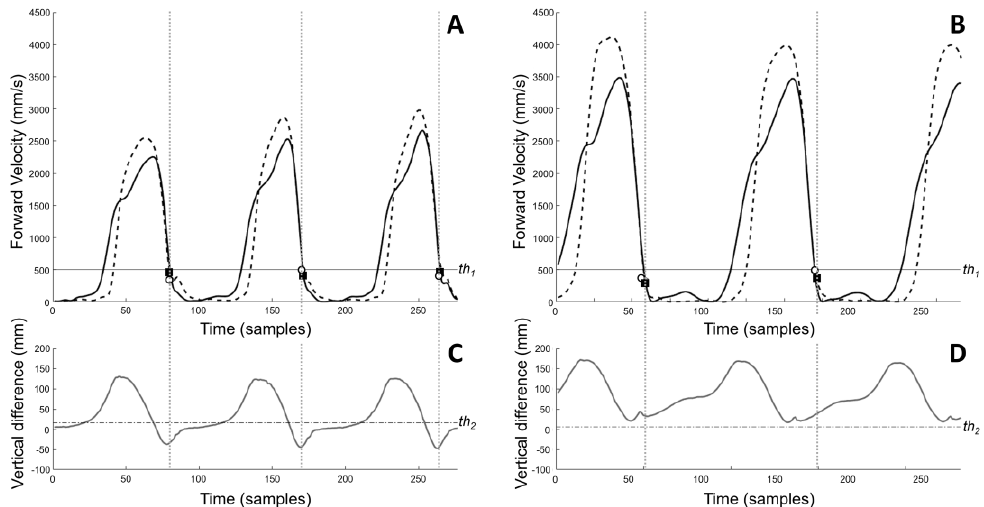
Figure 3. Top ( A , B ): Forward velocity of HEE (continuous thick black line) and TOE (dashed thick black line) for two trials representative of heel (left) and toe strike (right); horizontal thin continuous black line: th 1 . The white circles and black squares correspond to when the forward velocities of HEE and TOE fall below th 1 , respectively. Bottom ( C , D ): Difference of HEE and TOE vertical components (thick continuous grey line); horizontal thin dot − dashed grey line: th 2 . Depending on the value of this difference (below or above th 2 ) a heel or toe FS was identified. For heel FS when HEE and TOE forward velocity fell below th 1 (panel A ), the difference between HEE and TOE vertical components was less than th 2 (panel C ); the HEE marker (white circles in panel A ) was chosen as reference to identify FS . For toe FS when HEE and TOE forward velocity fell below th 1 (panel B ), the difference between HEE and TOE vertical components was greater than th 2 (panel D ); thus, the TOE marker (black squares in panel B ) was chosen as reference to identify FS.